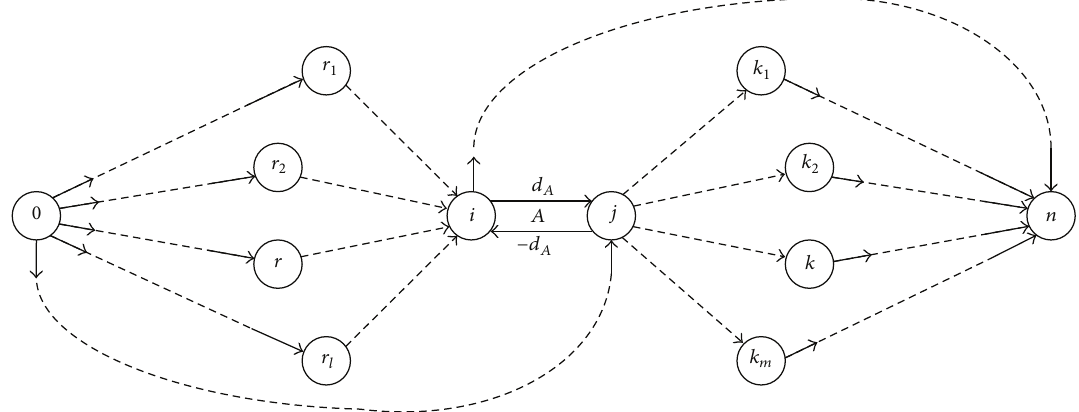
Figure 9: Diagram of paths passing the activity 𝐴 in an activity network under